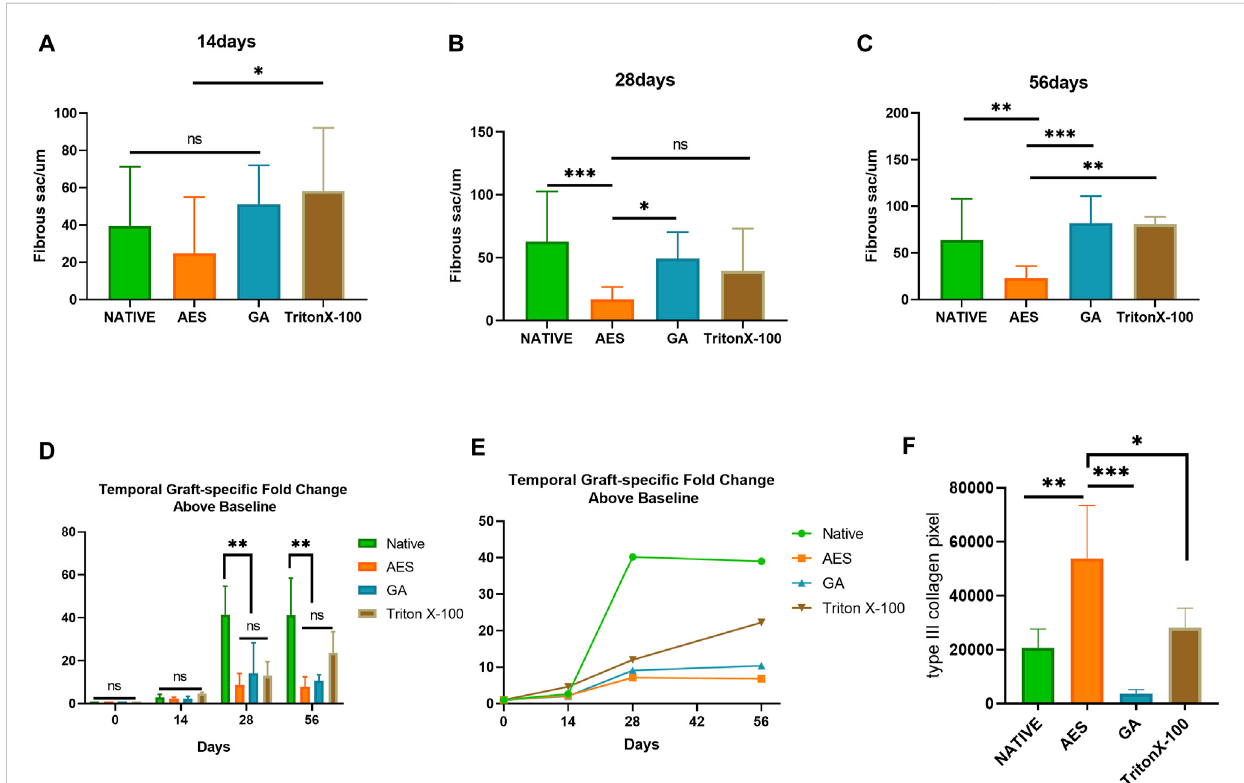
FIGURE 7 Fibroussacandgraft-speci fi chumoralimmuneresponseofeachsample.Fibroussacthicknessofeachgroupin14 days (A) ,28 days (B) ,56 days (C) (n = 15; * p < 0.05; ** p < 0.01; *** p < 0.001; ns represents no signi fi cant difference); (D , E) Temporal Graft-speci fi cFold Change AboveBaselineof Native, AES, GA, TritonX-100. (n = 3; * p < 0.05; ** p < 0.01; *** p < 0.001; ns represents no signi fi cant difference); (F) pixel area of type Ⅲ collagen by Picro-Sirius red staining. (n = 4; * p < 0.05; ** p < 0.01; *** p <